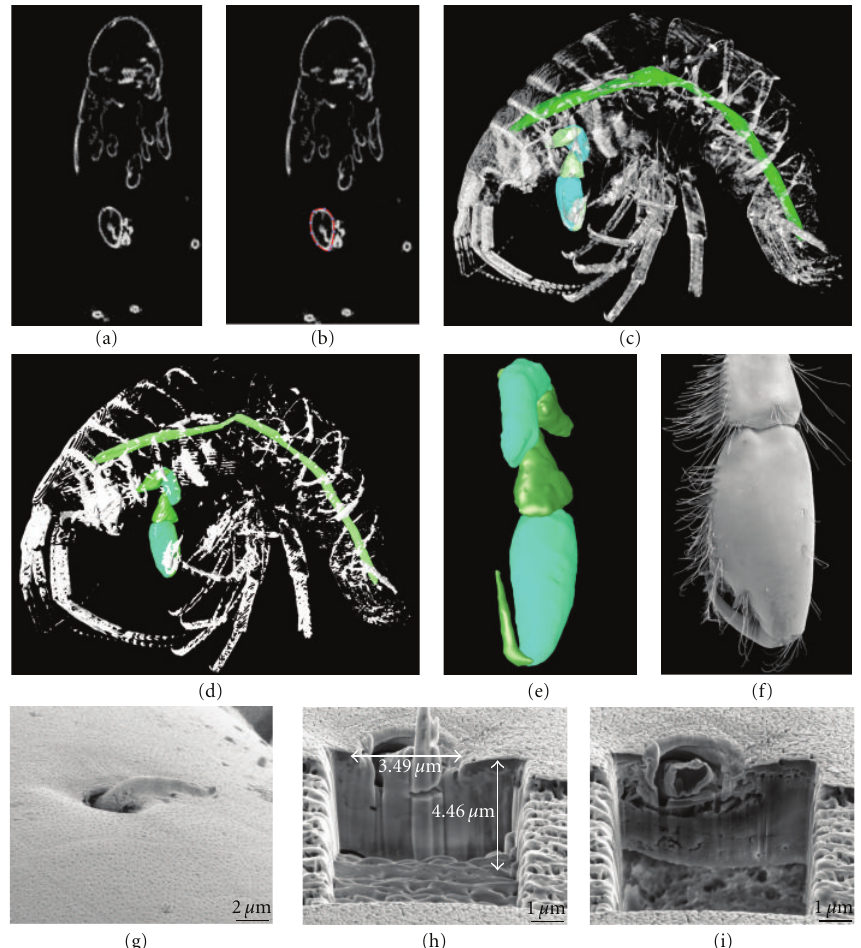
Figure 5: Micro-CT scans ((a)–(d)) and FIB SEM ((g)–(i)). (a) Single virtual slice of a complete microtomogram of a specimen of Gammarus roeselii. (b) The same image as (a). The outline of the gnathopod element has been marked in OsiriX (red). (c) Volume rendering of the entire microtomogram. The marked structures are the gnathopod and the gut. (d) Comparable image to (c) but now as a surface model. (e) Surface model of the gnathopod after further processing in the 3D-modelling software Blender. (f) The distal part of a right second gnathopod of Gammarus roeselii from posterior as SEM micrograph. (g) A sensillum on the surface of a second gnathopod of Orchestia cavimana. (h) Part of the surface close to the sensillum in (g) milled away. (i) Further milling gives access to the inner structure of the